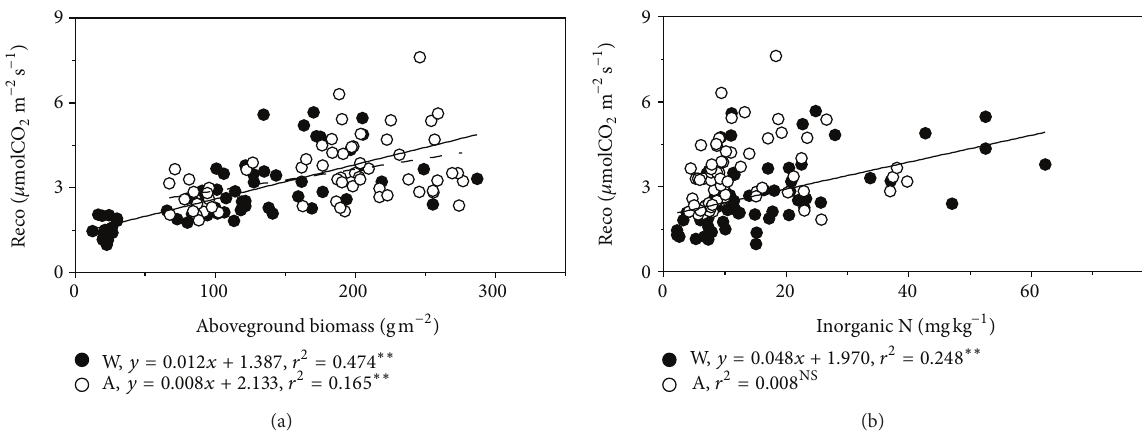
Figure 7: Dependence of soil respiration on aboveground biomass (a) and inorganic N content (b). Solid circles represent simulated warming treatment (W) and open circles represent ambient treatment (a). Regression lines are indicated only for significant correlations, with solid line and dash line for warming and ambient treatment, respectively.